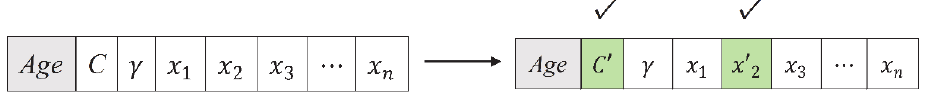
Fig. 4. Example of Global seeding operator in GSMOFOA with 𝐺𝑆𝐶 = 2 ; the new value of 𝑥 (cid:4593) , 𝐶 (cid:4593) will be randomly selected from the ranges of 𝐶 (cid:4593) ∈ [2 (cid:2879)(cid:2873) , 2 (cid:2869)(cid:2873) ] and 𝑥′ ∈ [ −